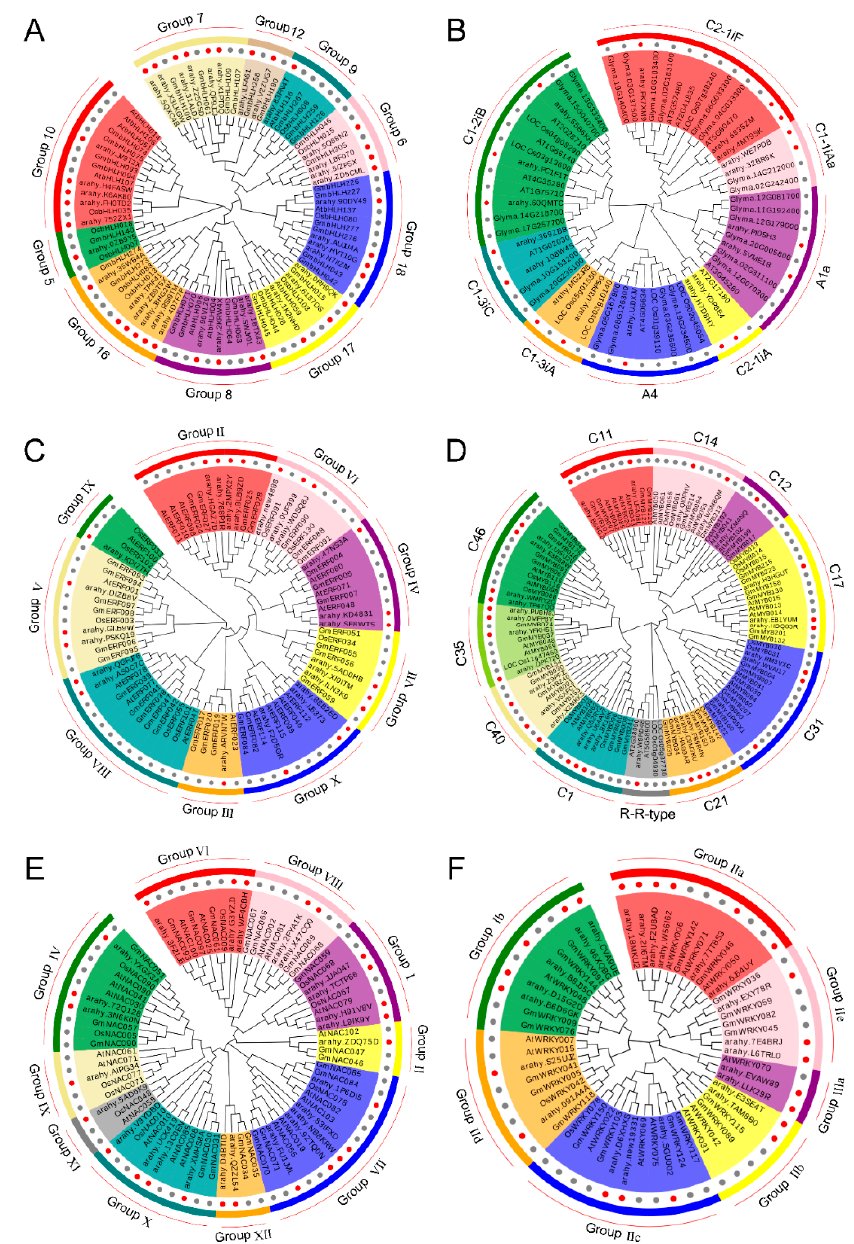
Figure 4. Phylogenetic relationships and subfamily designations of peanut transcription factor (TF) families along with model species Arabidopsis thaliana , Oryza sativa , and Glycine max . The colored branch indicates the different subfamilies. ( A ) bHLH (basic helix ― loop ― helix protein), ( B ) C2H2 ( Cys2/His2 zinc finger protein), ( C ) ERF (ethylene-responsive factor), ( D ) MYB (v-myb avian myeloblastosis viral oncogene homolog), ( E ) NAC (NAM, ATAF1/2, CUC2), and ( F ) WRKY. Red dots indicate peanut TF genes.